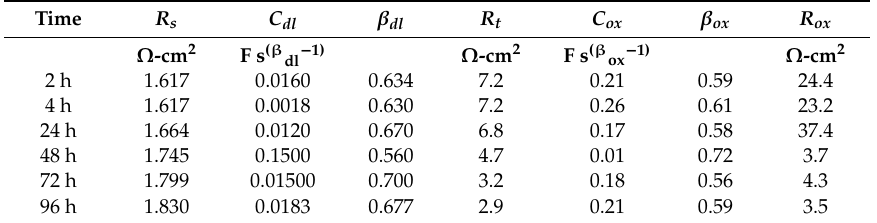
Table 8. Fitting results of the impedance spectra of Nickel alloy HR224 during corrosion in the presence of (LiNaK)NO 3 (ternary salt with lithium content) at 550 ◦ C.